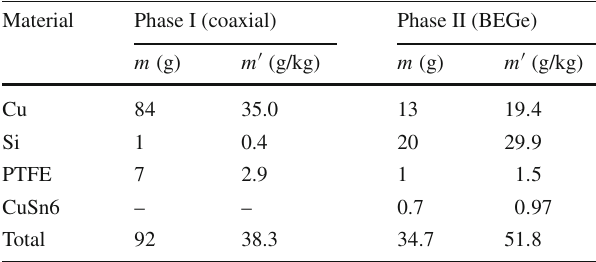
Fig. 3 Alternative mounts for pairs of and single BEGe detectors, and their connection to the signal and high voltage (HV) flexible cables. The single detector module is viewed from bottom Table 2 Comparison of the masses m of construction materials for the Phase I and II detector holders, and of the masses m (cid:5) normalized to 1kg of detector mass assuming an average mass of 0.67kg for single BEGe and 2.4kg for semi-coaxial